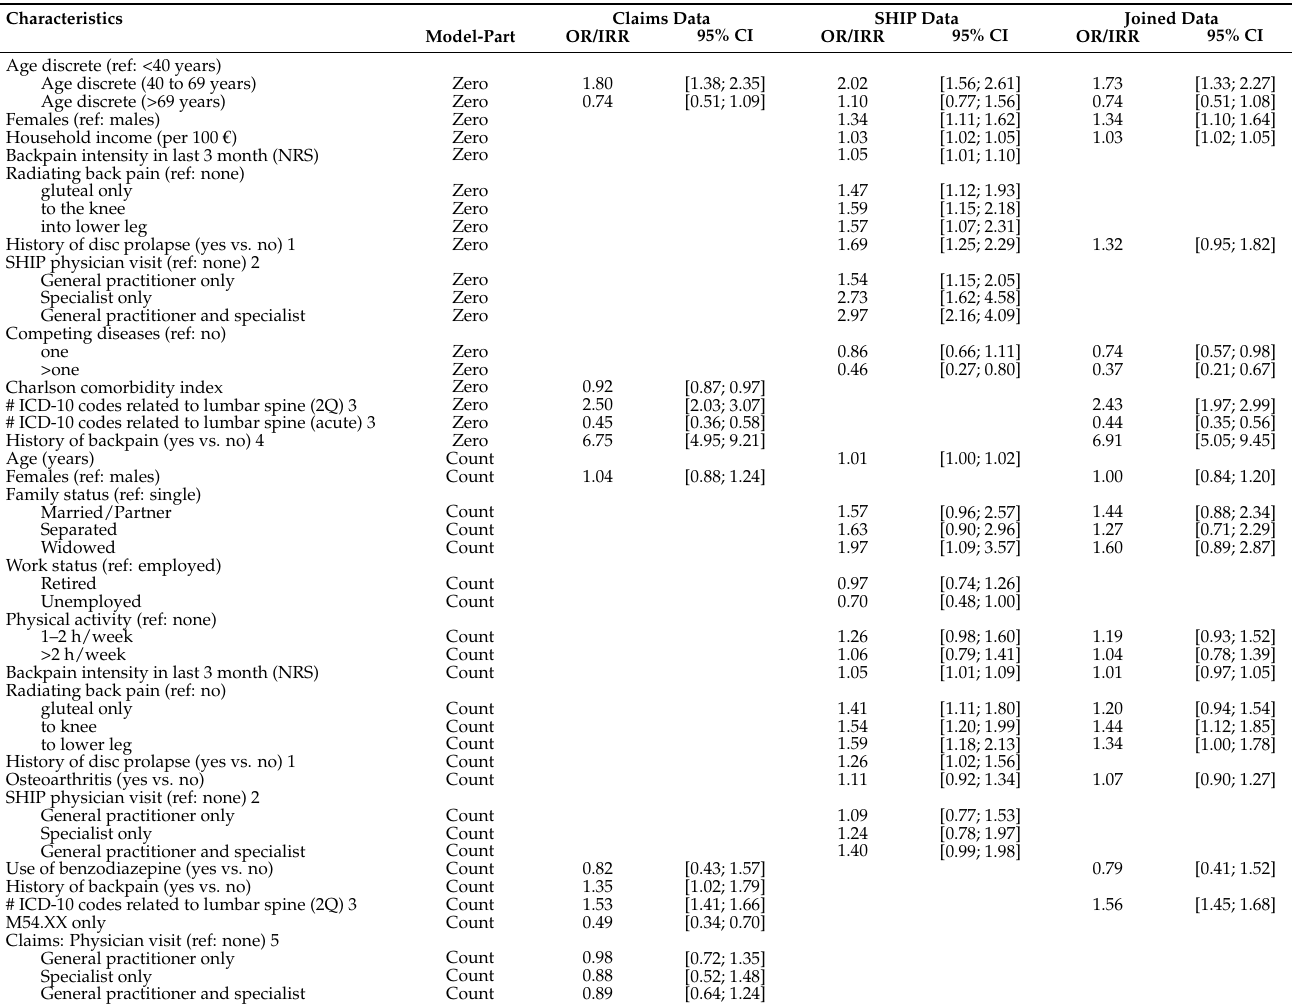
The table consists of two parts: the zero-part of the zero-inflated count data model, in which exponentiated coefficients correspond to odds ratios, and the count part, in which exponentiated coefficients can be interpreted as incidence rate ratios. 1 SHIP interview item: disc prolapse ever before SHIP, 2 SHIP interview item: physician visits within last 4 weeks, 3 No. of ICD-10 codes (2Q: codes must have been reported in two quarters of the baseline period of 12 month; acute: any of the code appeared within the quarter of the SHIP